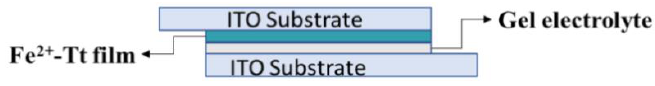
Figure 7. Scheme of the electrochromic device with a gel electrolyte.